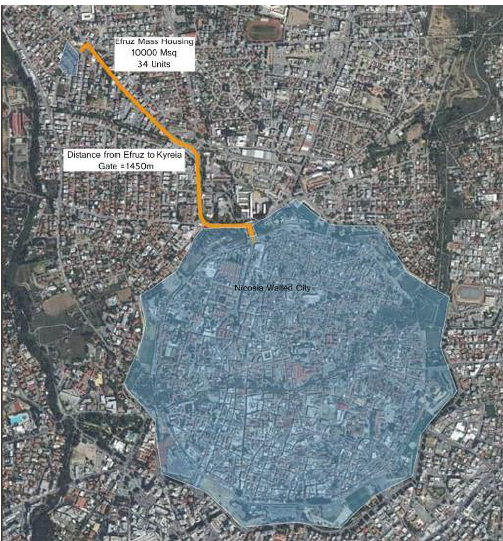
Figure 11. Efruz Massing housing in Nicosia Source (Image by Author from CartoDB GIS